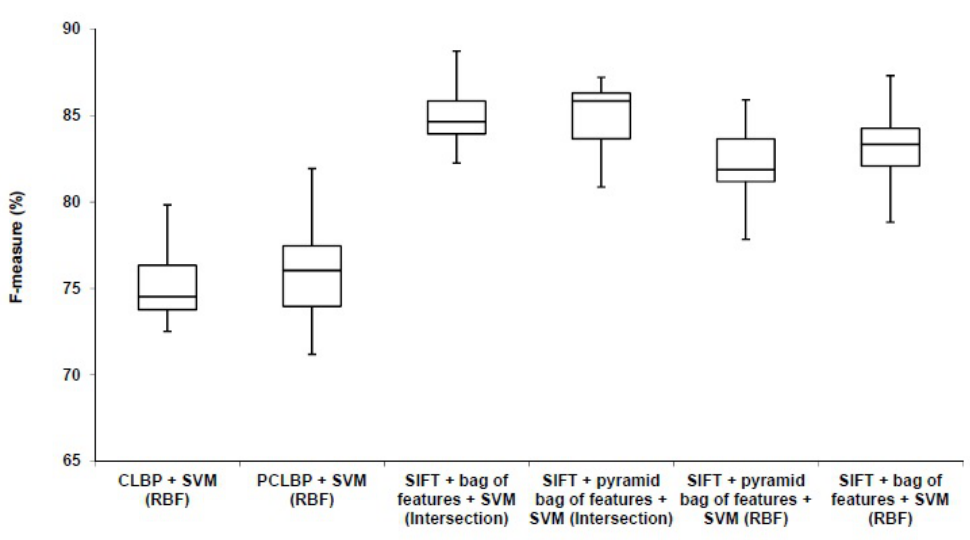
Figure 10. Comparison between our algorithm (SIFT + bag of feature) with the benchmarks (CLBP) and (PCLBP). Table 7. A representative confusion matrix for dataset from Children’s Hospital at